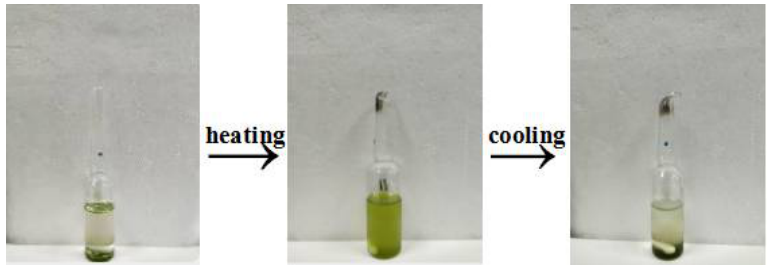
Figure 1. 1 H NMR spectrum of poly(ionic liquid) (PIL) with CDCl 3 and DMSO- d 6 as mixed solvents and tetramethylsilane (TMS) as an internal standard.